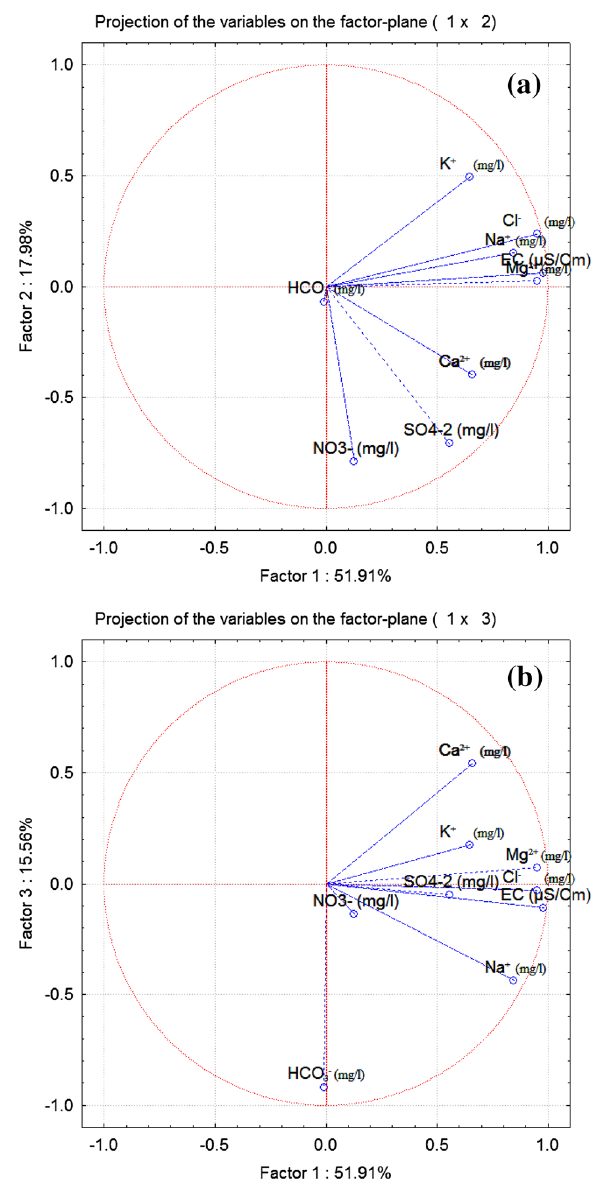
Fig. 10 Spatial distribution of the variables in the axes system a F1- F2 and b